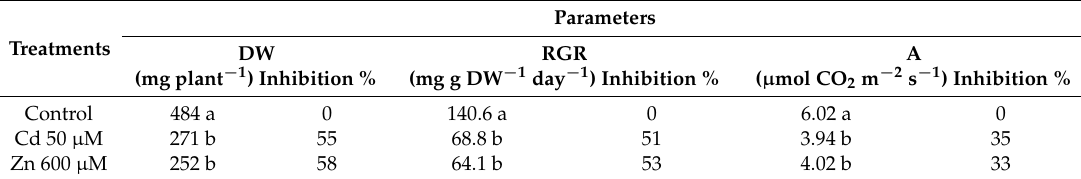
Table 1. Effects of Cd and Zn on growth parameters (DW—fresh weight, RGR—relative growth rate) and net photosynthetic rate (A) of durum wheat plants.